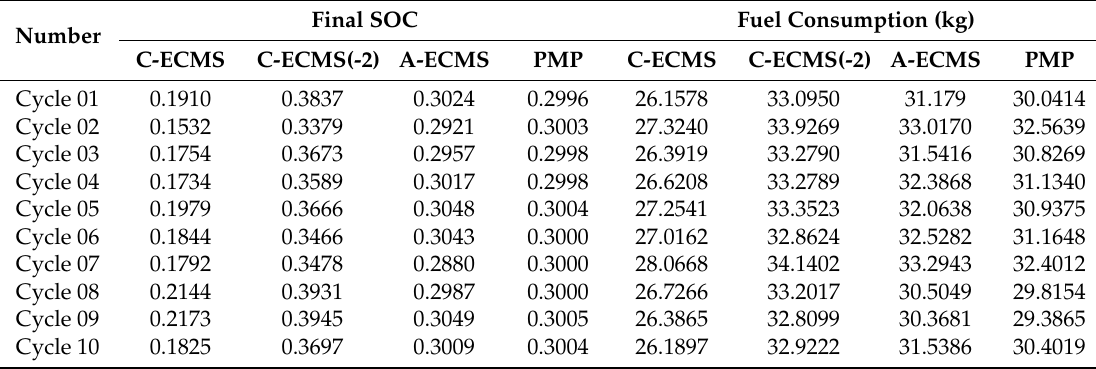
Table 8. Comparison statistics with initial SOC =